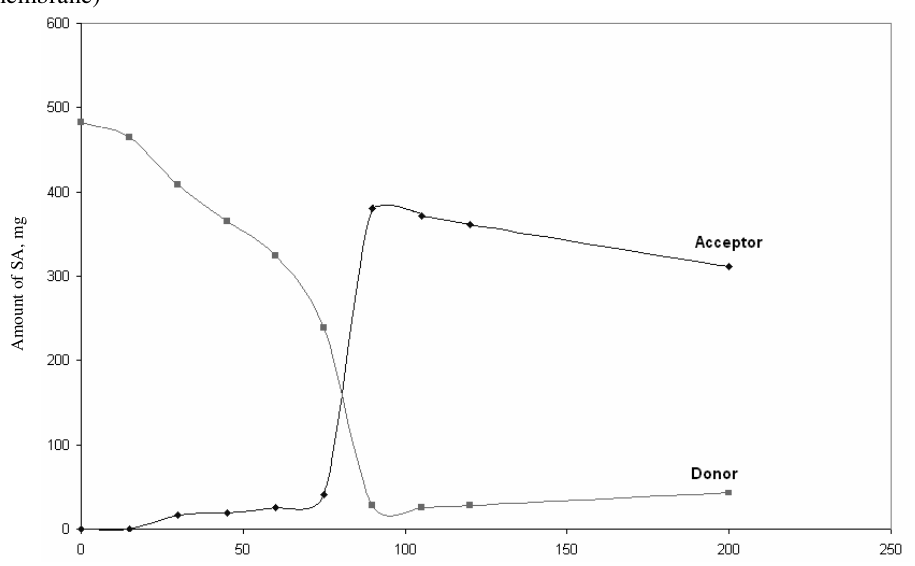
Figure 3. Effect of time of permeability of SA in donor and (PEG-Tannin membrane) Where C , C = concentration of SA in donor and receptor at initial C(o) and after time D R = effective cross-sectional area and diffusion in the hydrogel samples; W t, C(t). A H of the hydrogel sample and V=volume of SA solution in receptor and volume of